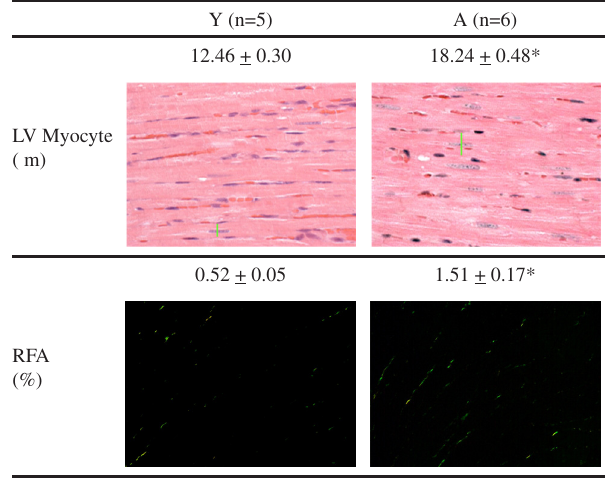
Table 2 - Histological analysis of LV myocyte diameter and relative fibrosis area (RFA)